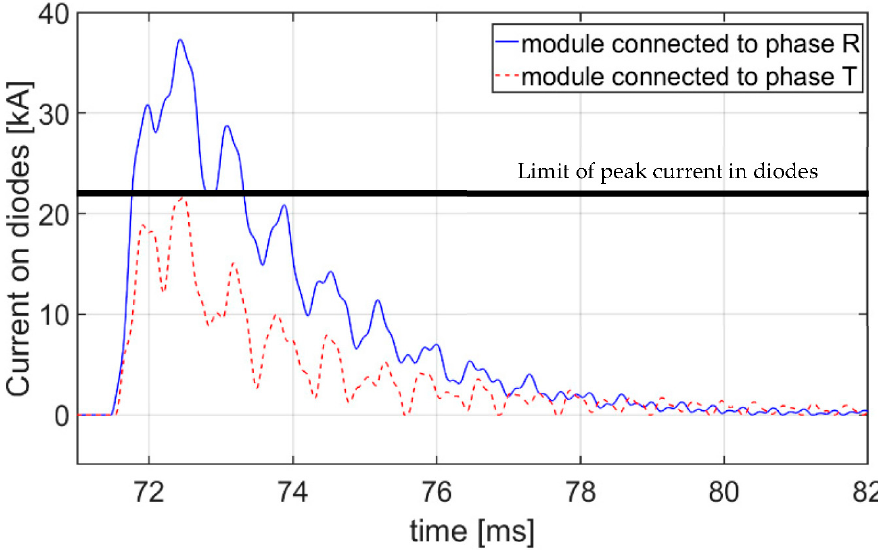
Figure 15. Current on diodes of the two healthy modules in the cubicle where an internal fault oc- curs during the AGPS operation. during the AGPS